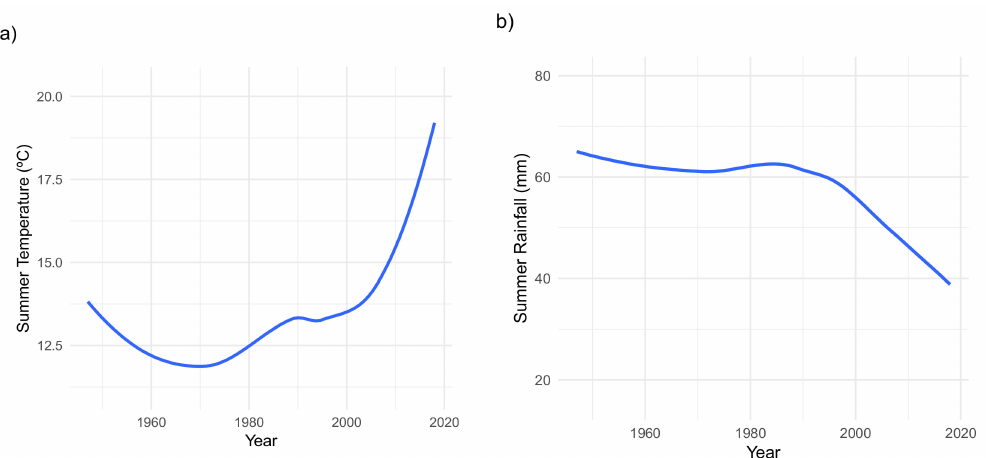
Figure 1. ( a ) Modeled data for temperature variations during the summer season in Mediterranean high-mountains of Sierra de Guadarrama (i.e., active growing season of S. carpetanus ) between 1946 and 2018; ( b ) modeled trend of the rainfall patterns befalling the summer season during the last 72 years in Sierra de Guadarrama high-mountain areas. In both graphics, the blue line corresponds to the modeled data; the gray area represents the “smoothed” parameter estimation.